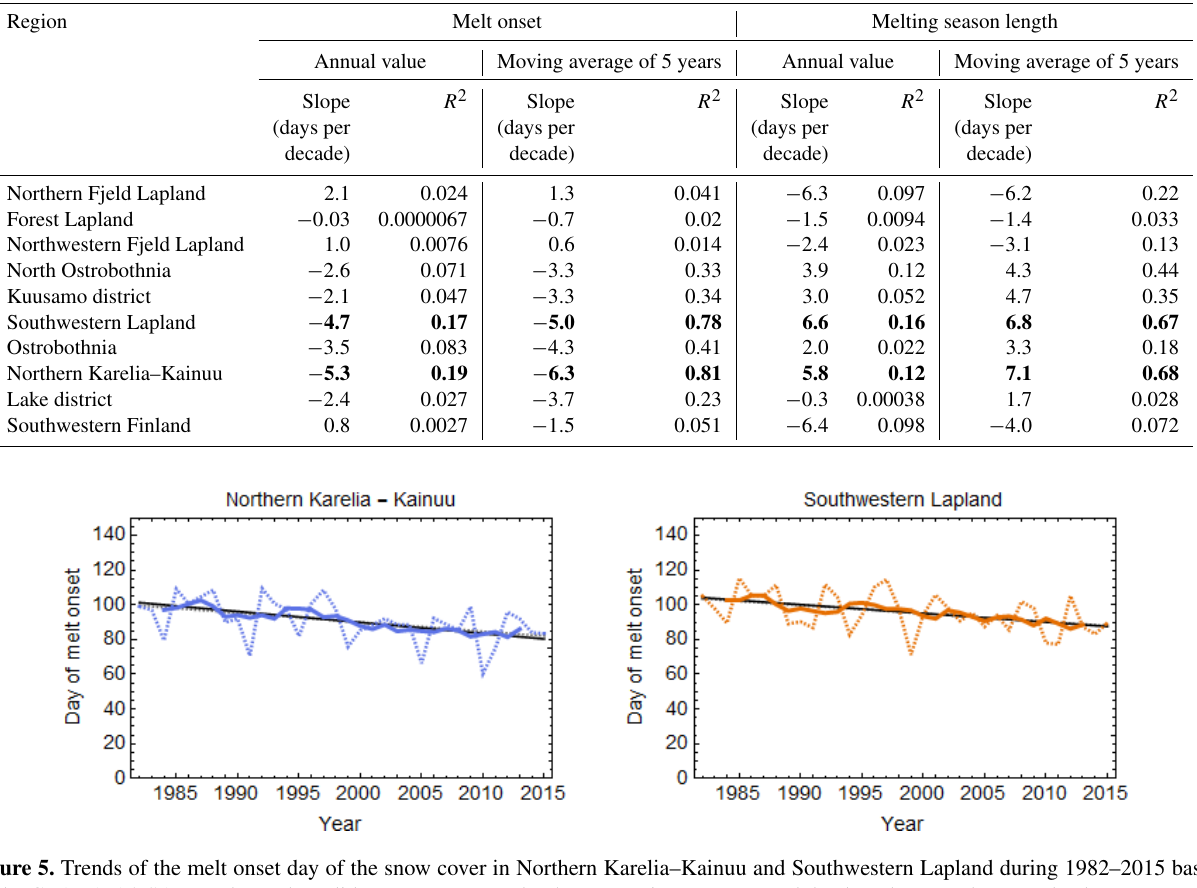
Table 3. The observed trends of the melt onset and melting season length during 1982–2015 according to the CLARA-A2 SAL data of the regions based on the vegetation zones (Table 1). Values for the slope and the coefficient of determination are shown both for annual data and for moving averages of 5 years. The cases for which the moving average of 5 years shows a significant coefficient of determination are indicated with bold fonts.